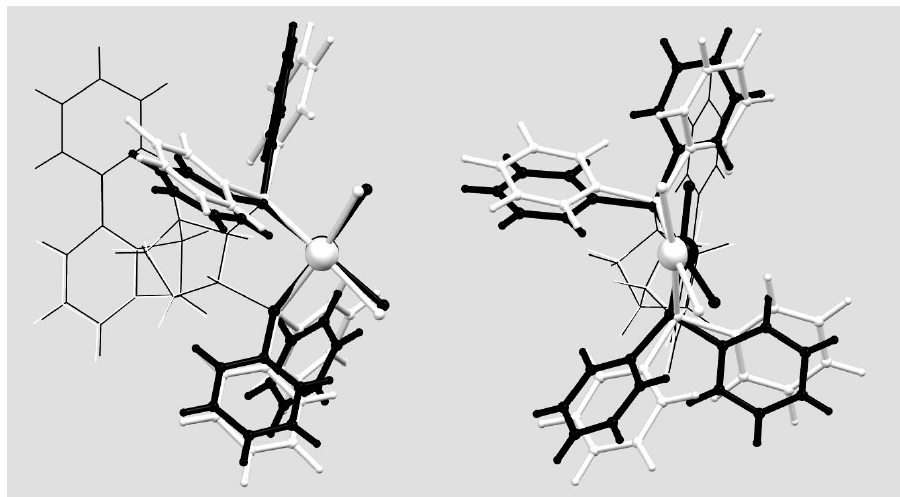
Figure 5. The structural overlay of the molecules of the coordination compounds [Pd( 6q )Cl 2 ] xray and [Pd( 6q )Cl 2 ] calc : front and side views. Black: measured X-ray structure [Pd( 6q )Cl 2 ] xray , white: calculated geometry of [Pd( 6q )Cl 2 ] calc . The fragments that match are marked with thin lines.